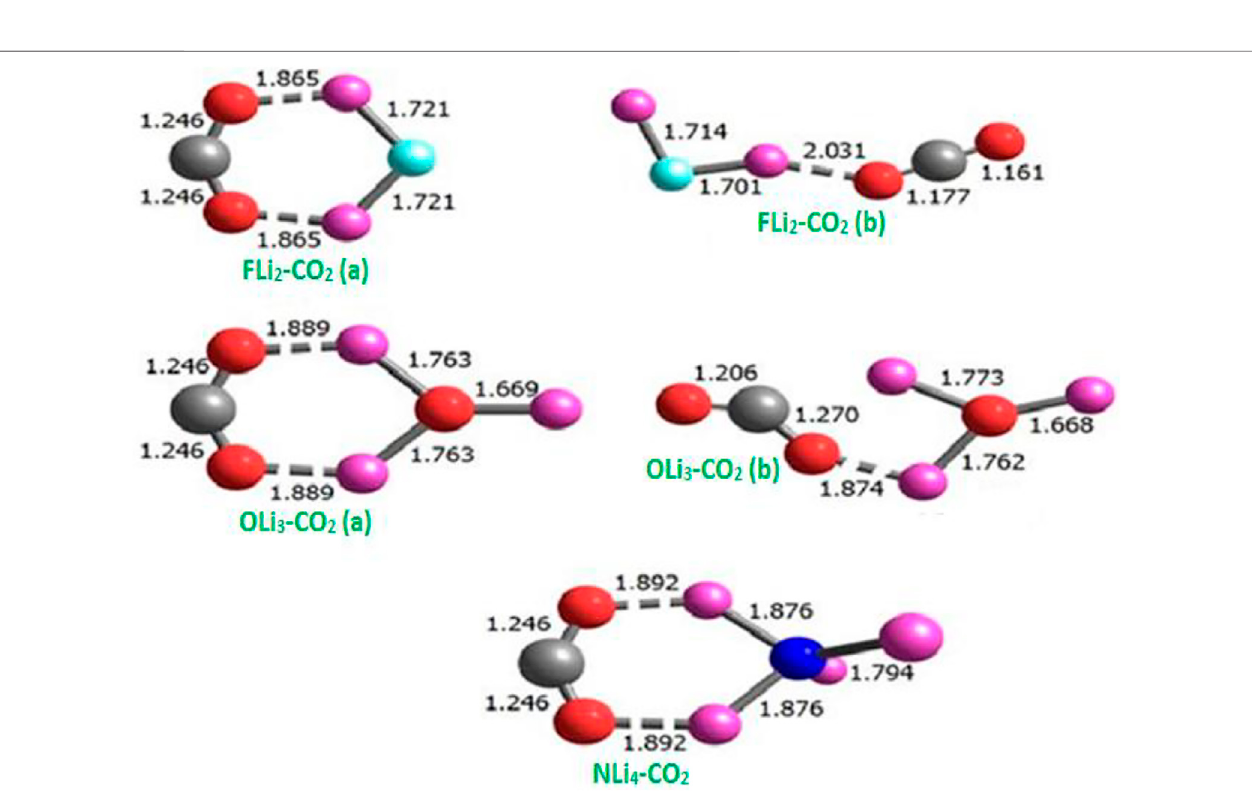
Frontiers in Physics |